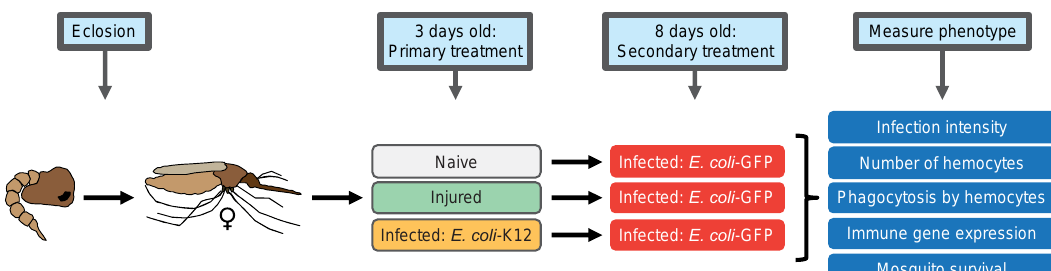
Figure 1. Diagrammatic representations of the experimental approach. At 3 days after eclosion, mosquitoes were subjected to one of three primary treatments: naïve (unmanipulated), injured, or infected with E. coli -K12. At day 8, all the mosquitoes were infected with E. coli -GFP and several phenotypes were measured. Infection intensity was measured at 1, 3, and 7 days after the E. coli -GFP infection. The number of hemocytes and immune gene expression were assayed 1 day after the E. coli -GFP infection. Phagocytosis was measured 1 hr after the E. coli -GFP infection, and survival was tracked every day after the E. coli -GFP infection until all the mosquitoes had died.